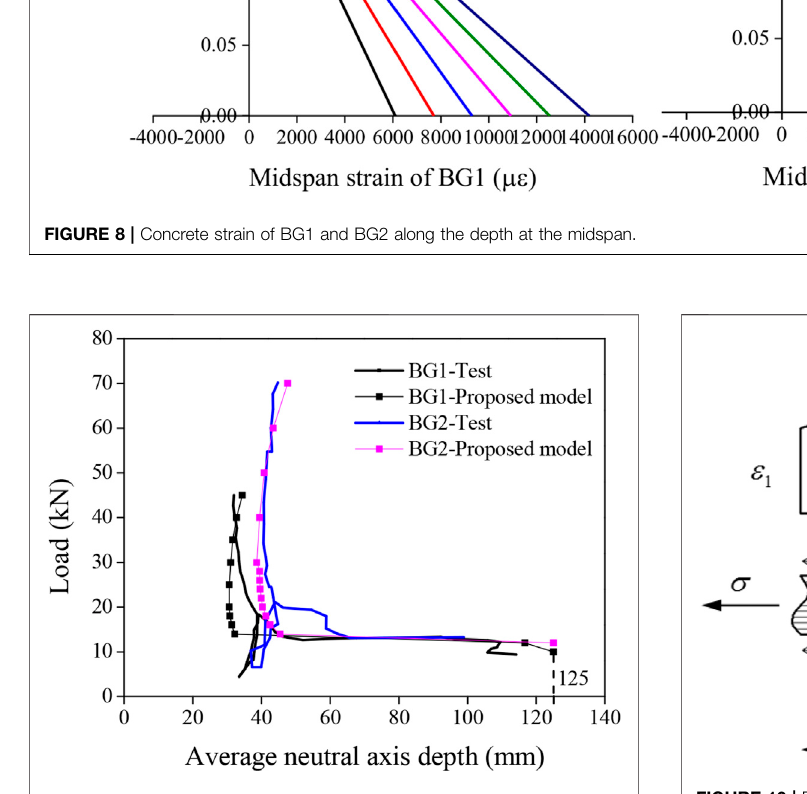
FIGURE 10 | Bond behaviour of a segment of FRP